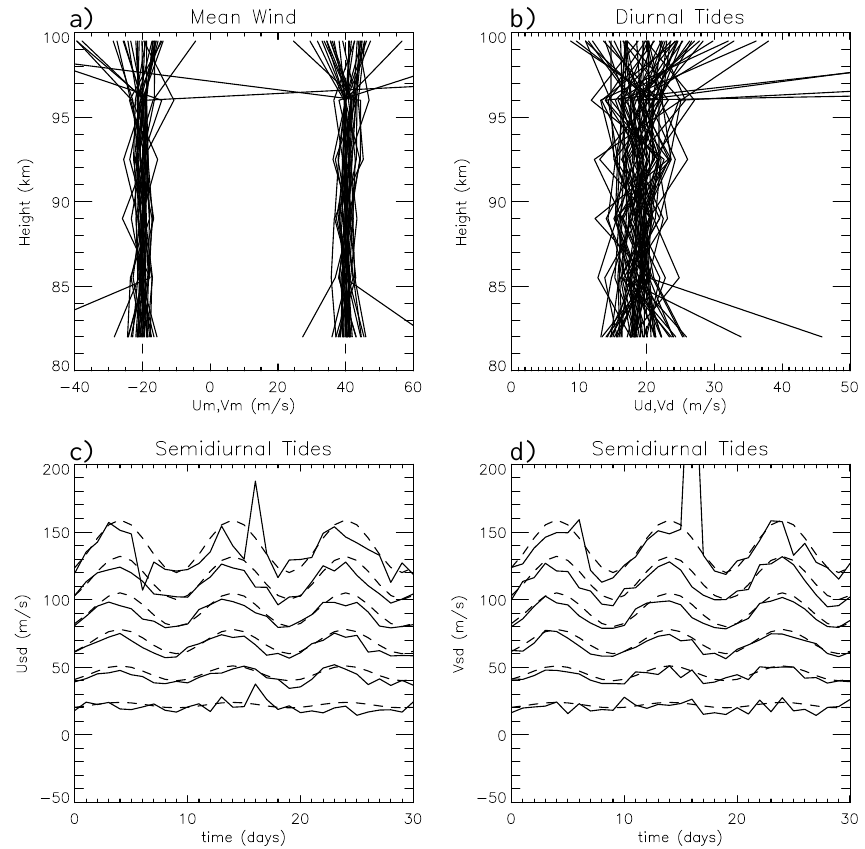
Fig. 15. (a) Daily zonal ( ∼ 40ms − 1 ) and meridional ( ∼ − 20ms − 1 ) mean winds, (b) diurnal tide amplitudes, and (c) and (d) semidiurnal tide amplitudes for 1-day fits (solid) to the specified motion field in Case 3 (dashed lines) assuming the meteor distribution observed for January 2005. Successive profiles in panels (c) and (d) are offset by 20ms − 1